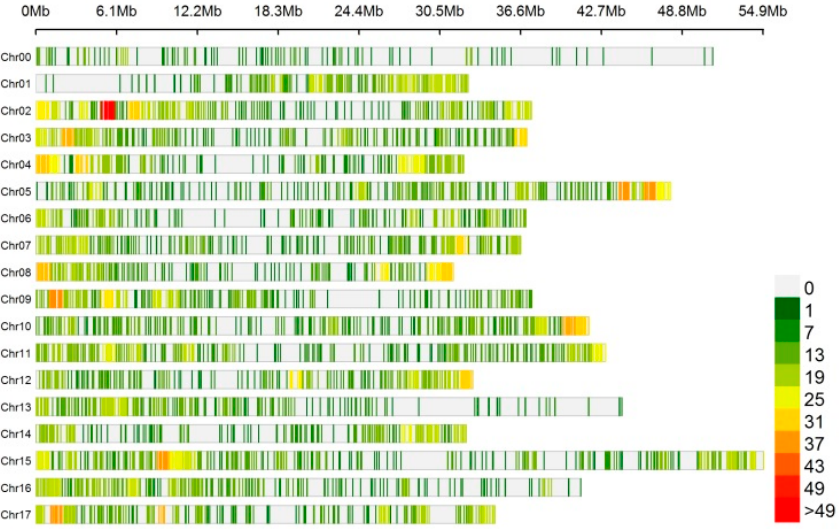
Figure 1. Distribution of circRNAs identified in chromosomes.